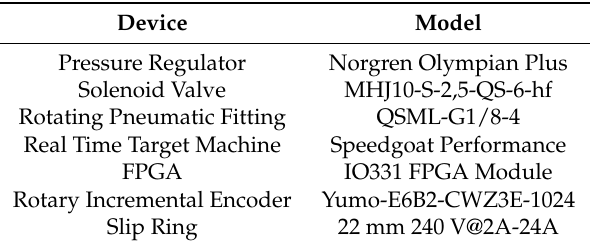
Table 2. Experimental test setup